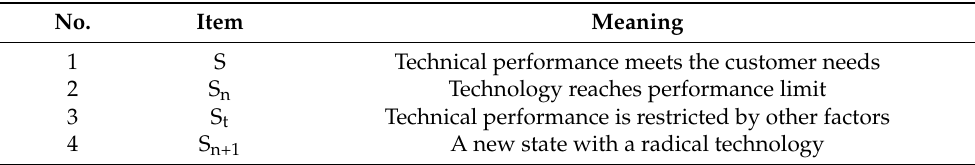
Figure 3. Analysis of radical technology opportunities. Table 1. List of Items for Technological